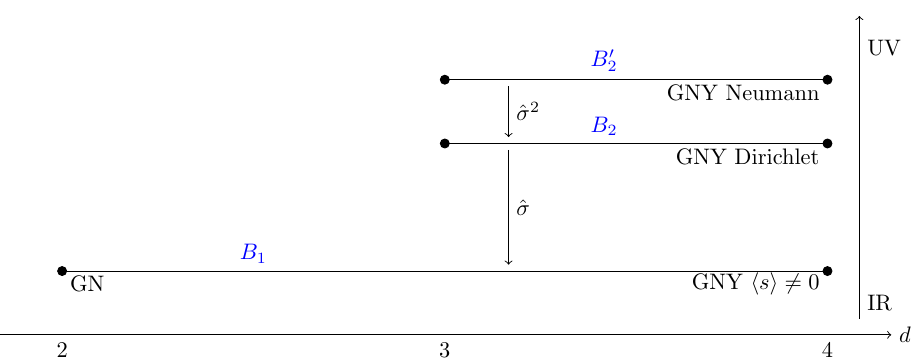
Figure 1 . Various boundary phases for the large N model and their description in terms of Gross-Neveu and Gross-Neveu Yukawa model near d = 2 and 4 respectively. The figure is not to scale, and the top two phases can only be distinguished at subleading order in 1 /N